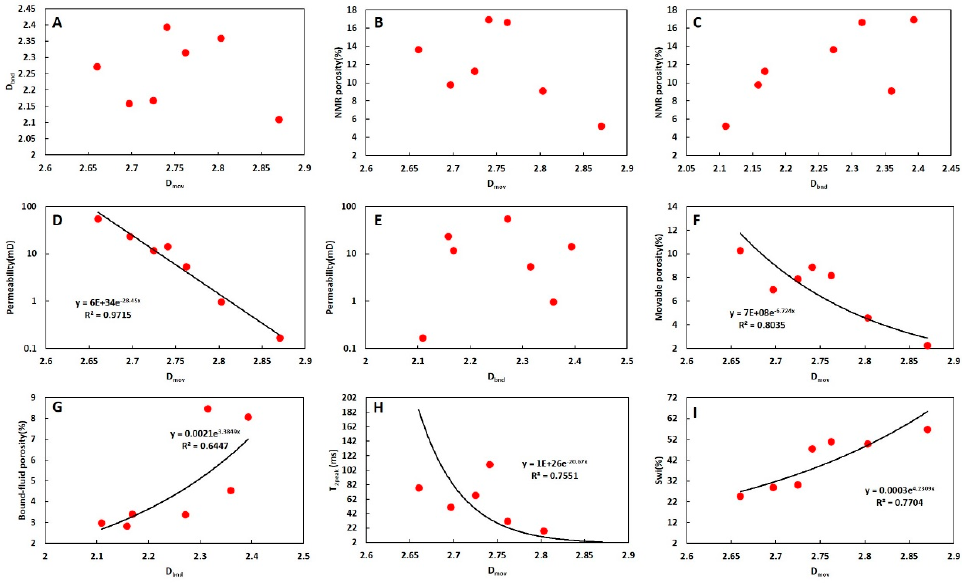
Figure 15. Plot showing the relationships between ( A ) D mov and D bnd ; ( B ) D mov and NMR porosity; ( C ) D bnd and NMR porosity; ( D ) D mov and Permeability; ( E ) D bnd and Permeability; ( F ) D mov and Movable-fluid porosity; ( G ) D bnd and Bound-fluid porosity; ( H ) D mov and T 2peak ; ( I ) D mov and Swi.